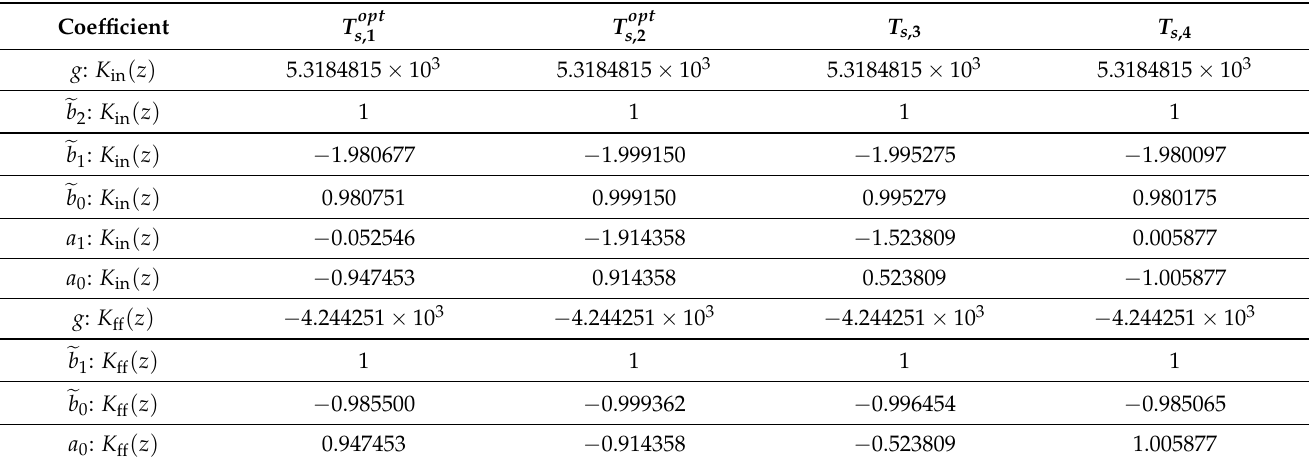
Table 8. DC motor case study discrete-time ideal coefficients using the deduced sampling